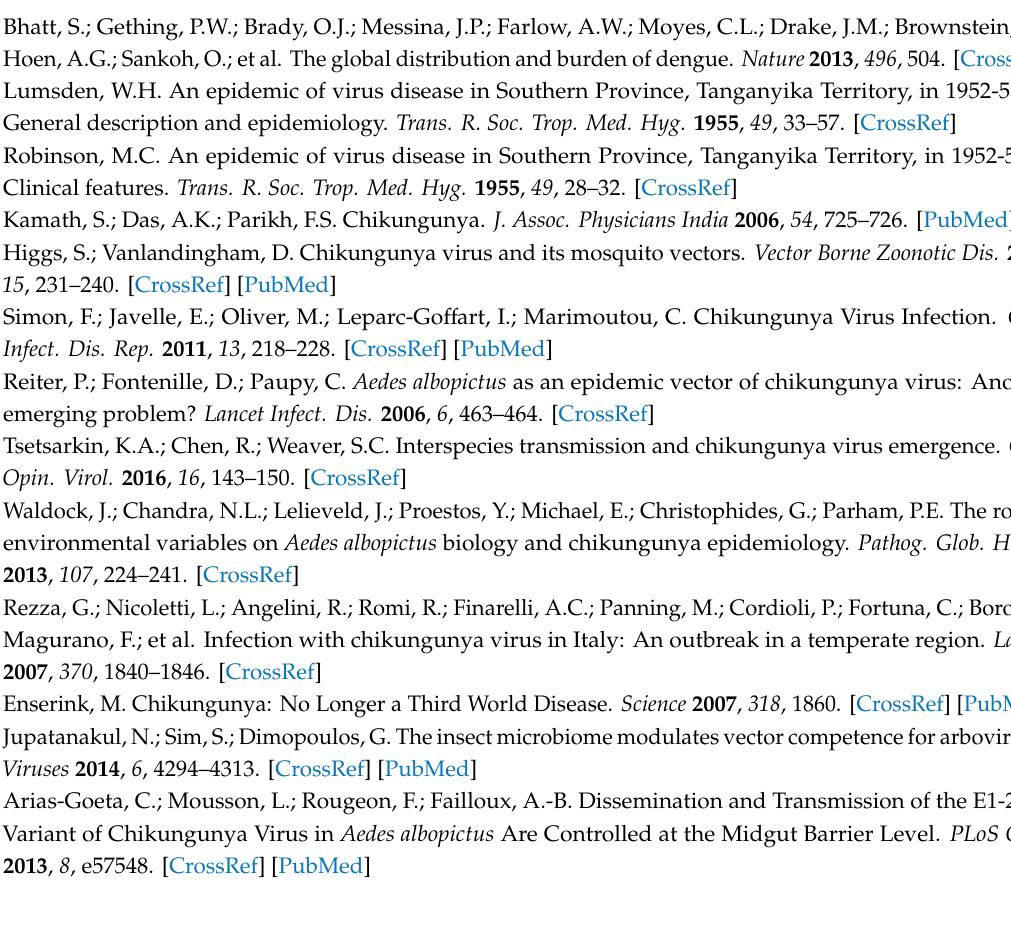
Table S1: List of primers, S2: List of di ff erentially expressed genes, S3: Custom transcriptome